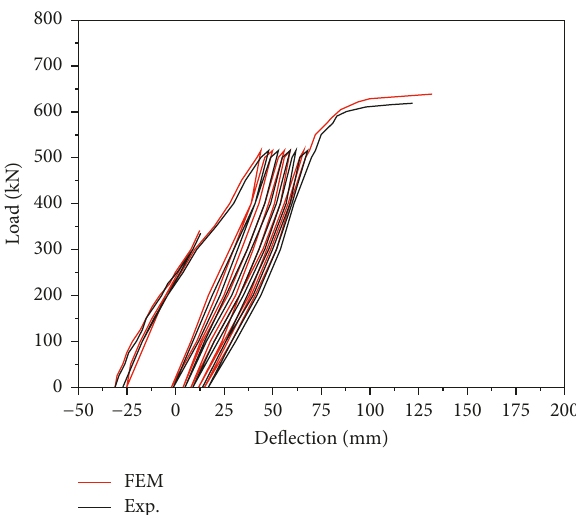
Figure 20: Finite element mesh and loading arrangement. (a) Girders G1 and P1. (b) Girders G2 and P2.